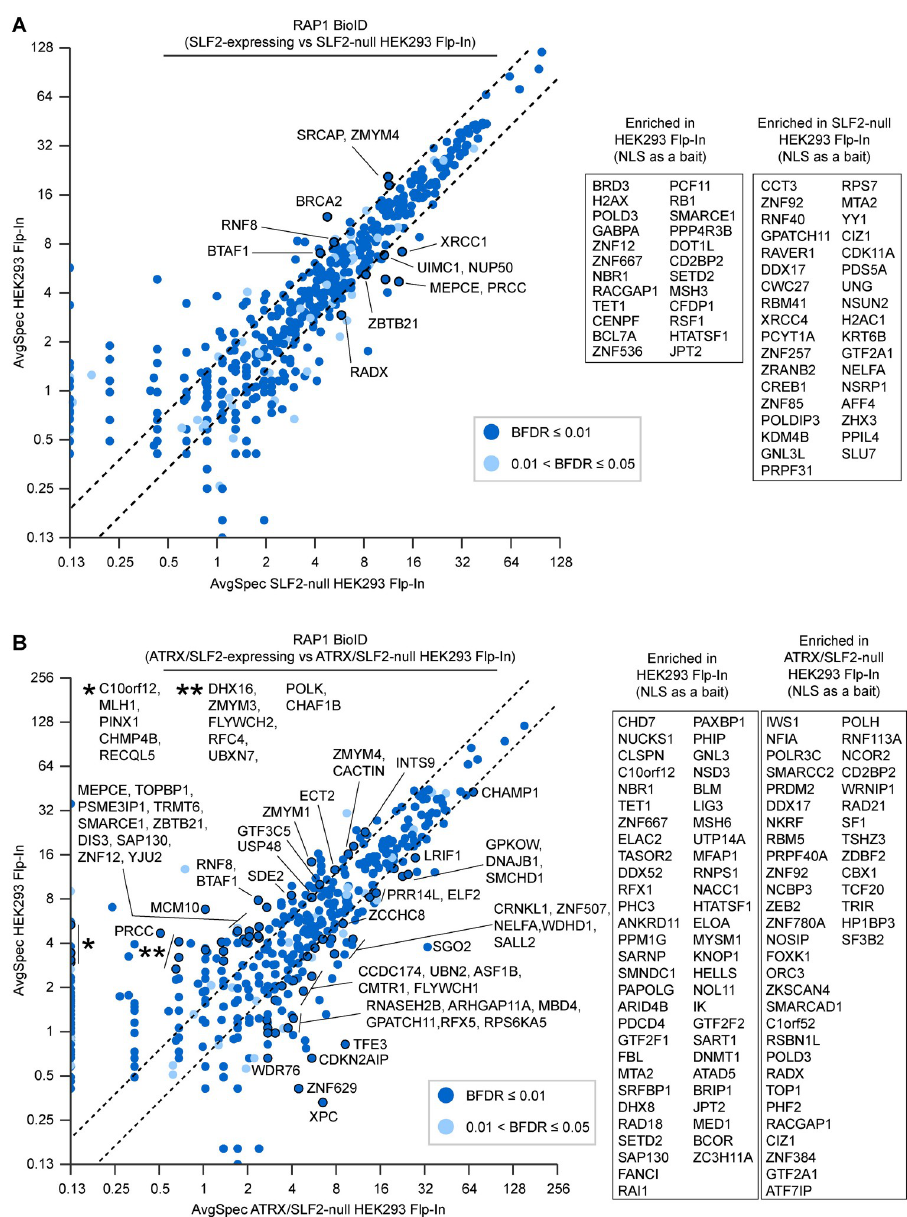
Fig 6. Changes at telomeres caused by a loss of SLF2 and ATRX. Fold change of prey proteins identified by RAP1 BioID (BFDR � 5%, SAINT [103]) in A: SLF2-null, and B: ATRX/SLF2-null vs. ATRX- and SLF2-expressing HEK293 Flp-In cells. Labeled proteins had � 2.5 average spectra and � 1.5-fold change between conditions. Proteins labeled in the scatter plot remained significant when NLS-BirA � was used as a control. Inset box represents additional proteins identified with NLS-BirA � as a bait (less